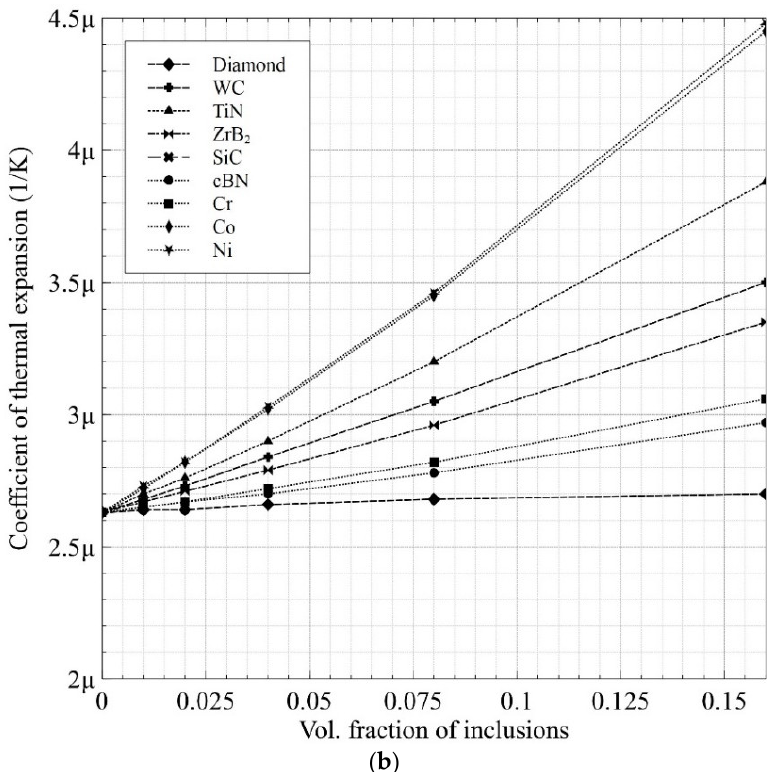
Figure 4. Predicted effective: ( a ) elastic modulus and ( b ) coefficient of thermal expansion of Ca-α- SiAlON composites as a function of volume content of potential metal and ceramic reinforcements.